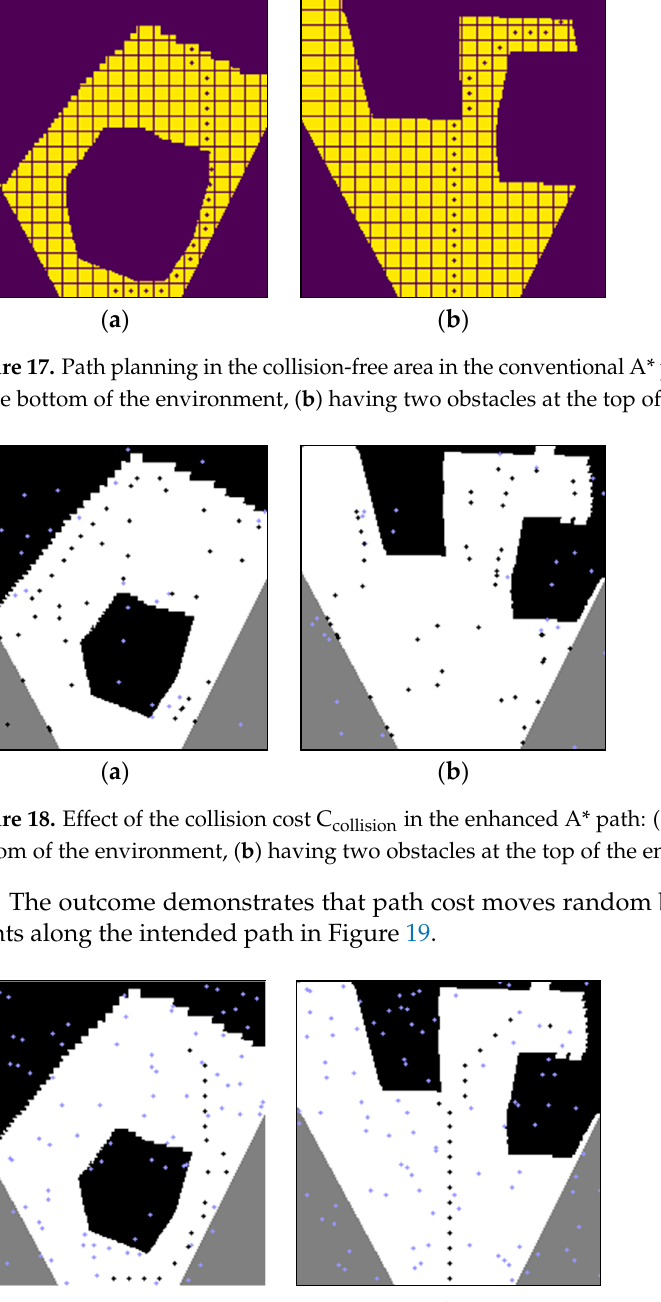
Figure 17. Path planning in the collision-free area in the conventional A* path: ( a ) having one obstacle at the bo tt om of the environment, ( b ) having two obstacles at the top of the environment.